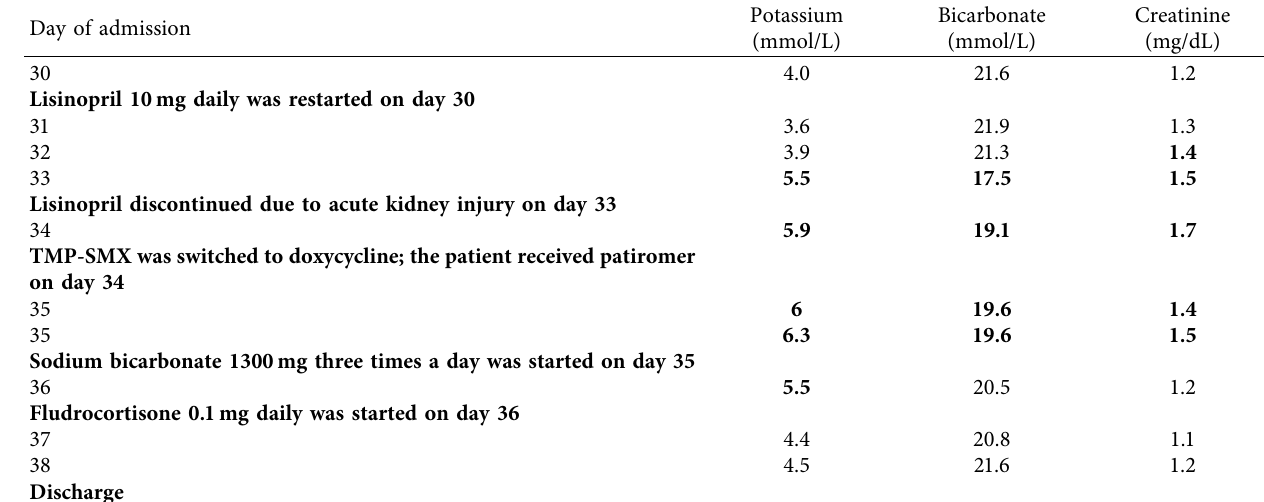
Table 1: Hospital course timeline starting from day 30; medication management; serum potassium, bicarbonate, and creatinine